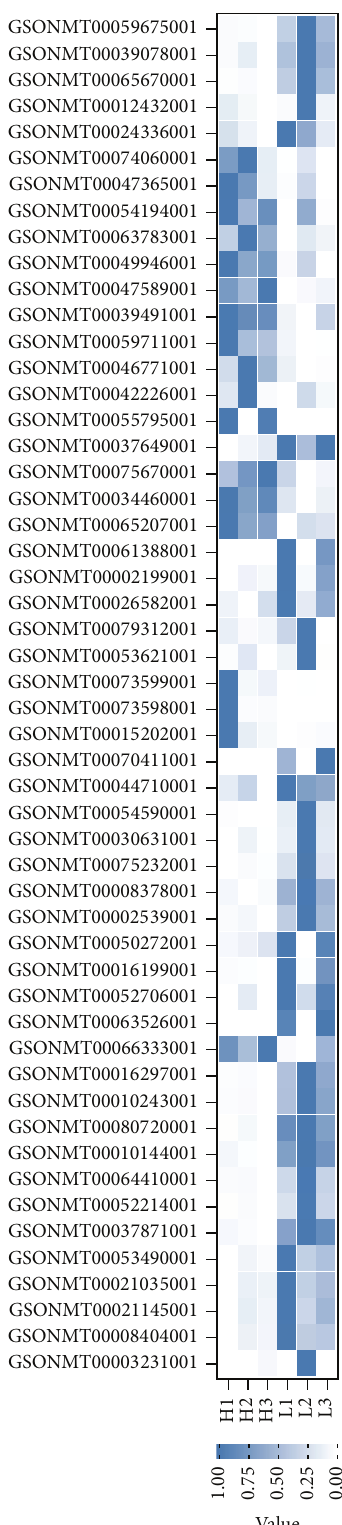
Figure 3: Heat map showing the expression profiles of differentially significant transcripts involved in lipid metabolic processes. A total of 52 of 372 transcripts involved in lipid metabolic processes (GO: 0006629) were differentially expressed between the high and low carcass fat content fish groups. H1, H2, and H3 represent the first, second, and third fish in the high carcass fat content group, respectively; L1, L2, and L3 represent the first, second, and third fish in the low carcass fat content group, respectively. Colored bars indicate relative expression levels. Transcripts expressed at higher levels were assigned blue, while transcripts expressed at low levels were assigned